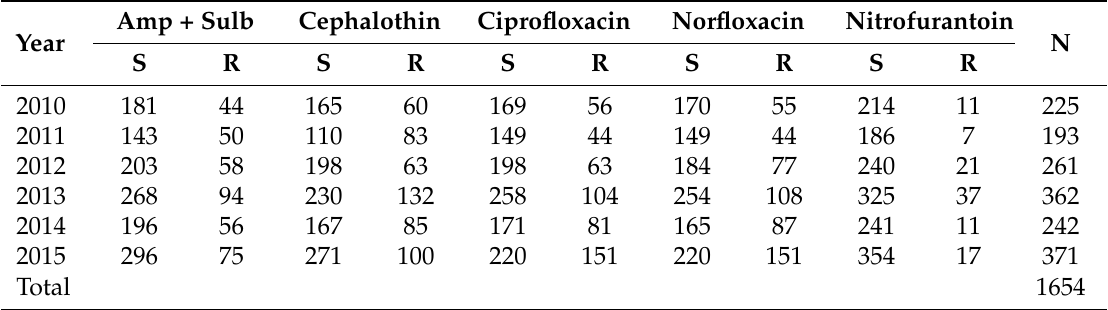
Absolute values of antimicrobial sensitivity in urocultures positive for E. coli from outpatients,